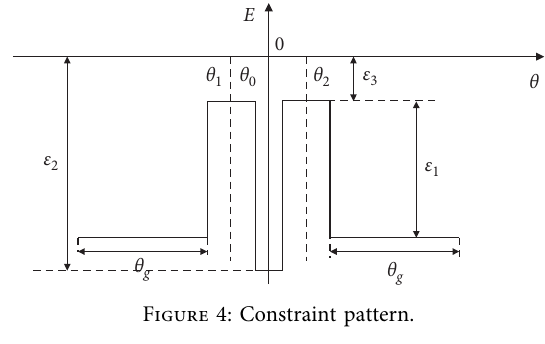
Figure 4: Constraint pattern.